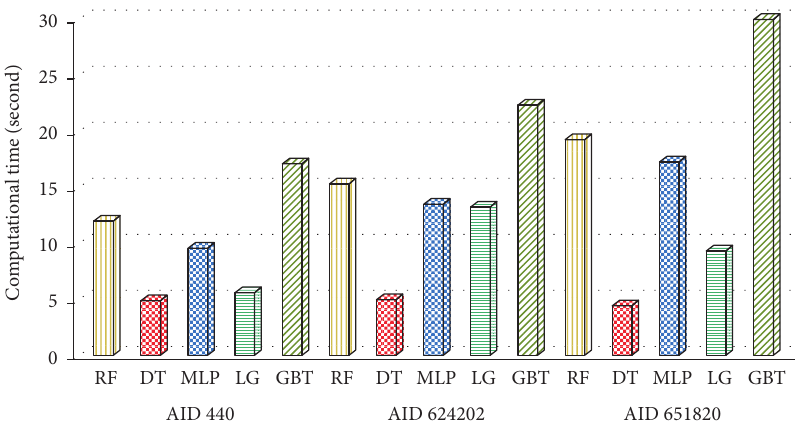
Figure 12: Comparison of computational time (seconds) in KSMOTE for the fingerprint PaDEL